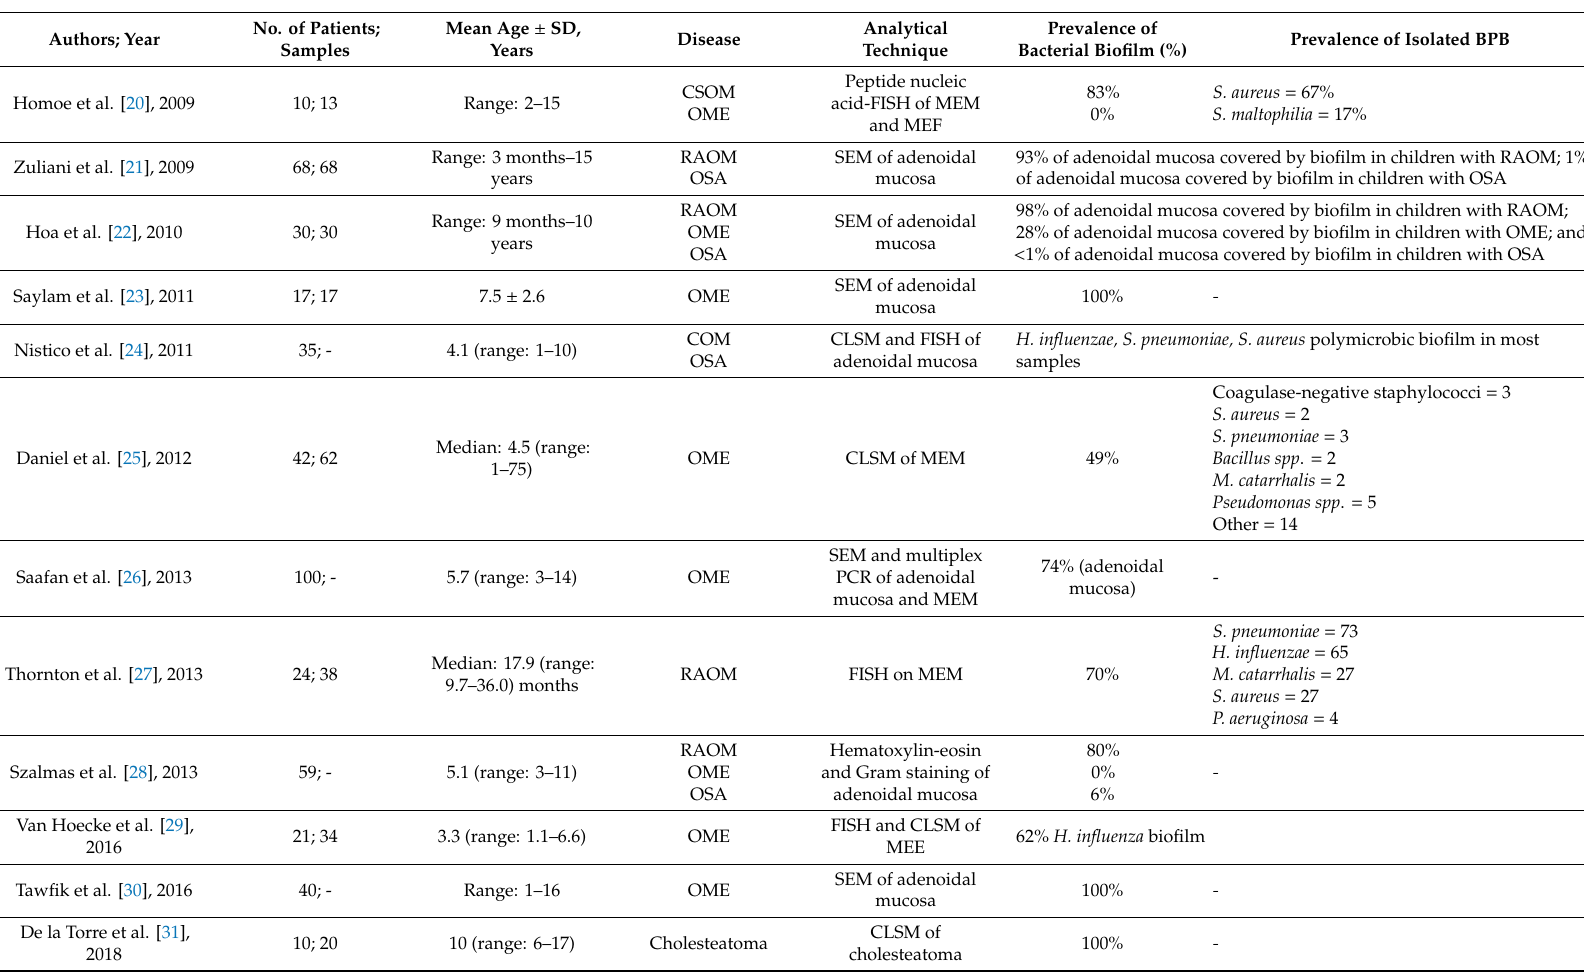
Table 2. Main characteristics and related microbiological findings of the main studies of bacterial biofilm in recurrent / chronic middle ear diseases. Authors;